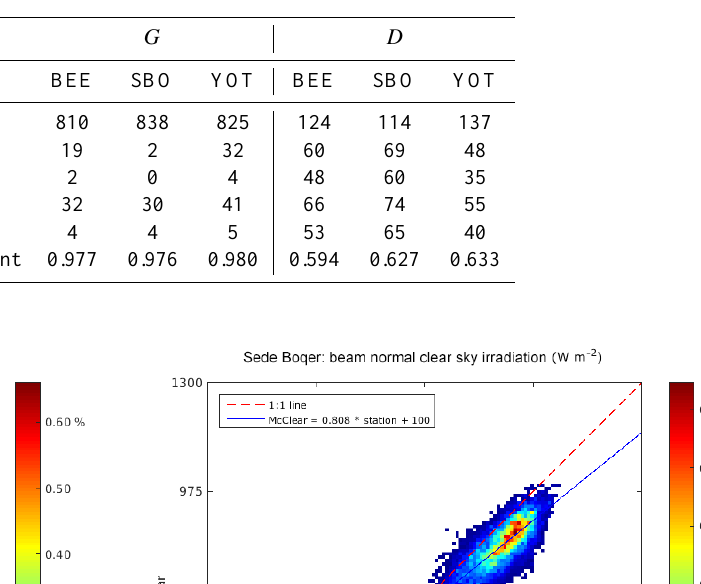
Table 2. Comparison between clear-sky global G and diffuse D SSI measured by ground stations and estimated by McClear. Units in Wm − 2 .